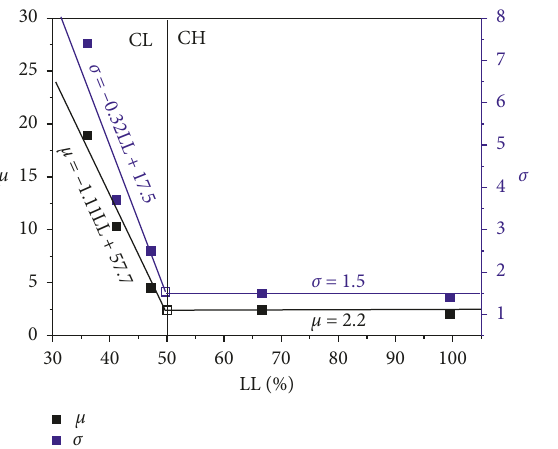
Figure 5: Relationship between normal distribution parameters and soil LL.